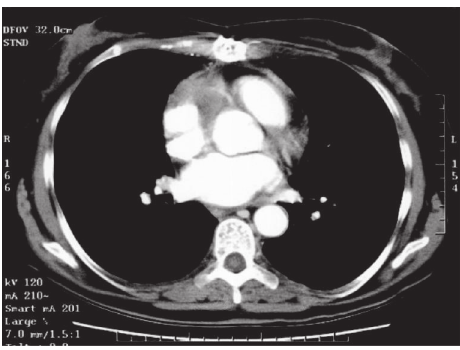
Figure 1: Cardiac mass on CT scan before chemotherapy.